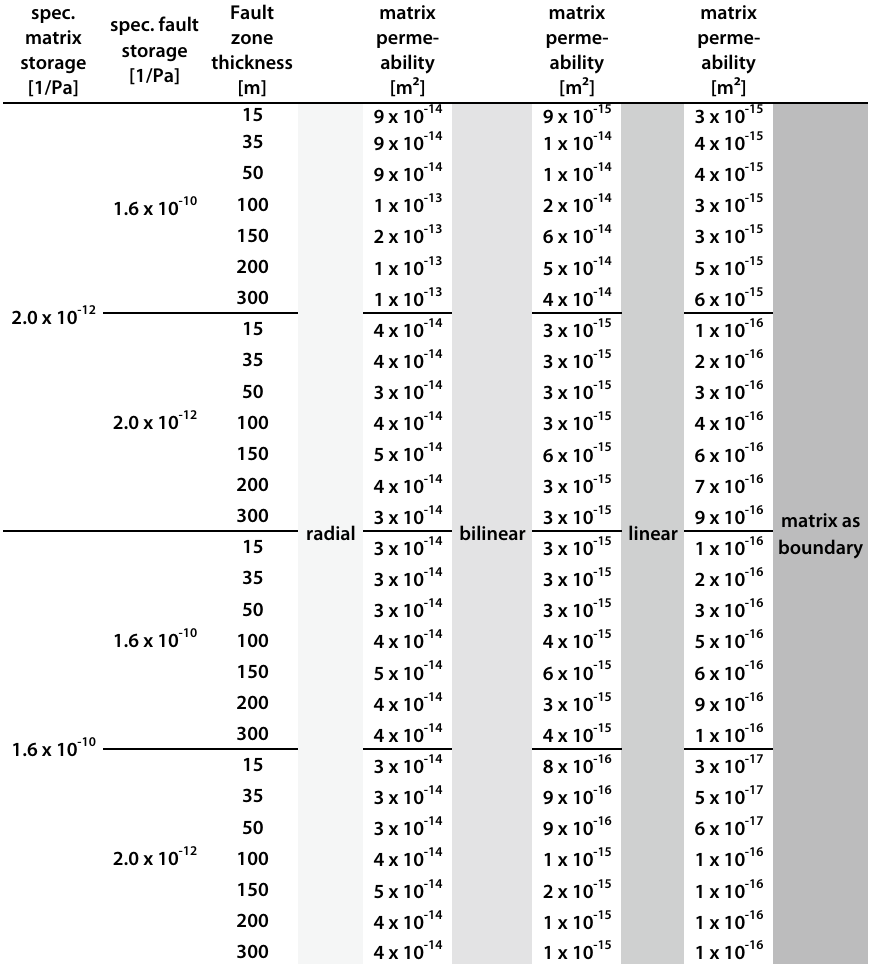
Table 5 Matrix permeability values are shown below which the flow regime noted to its right is possible spec.